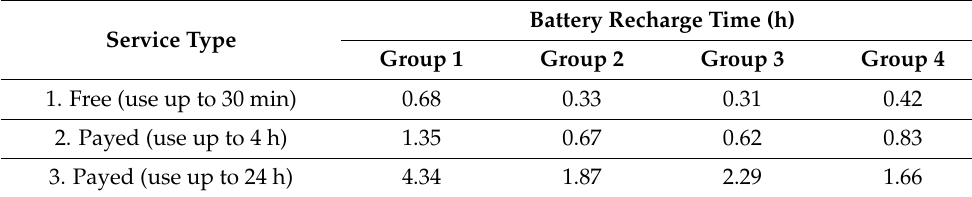
Table 9. Battery recharge time for each group in different service types.